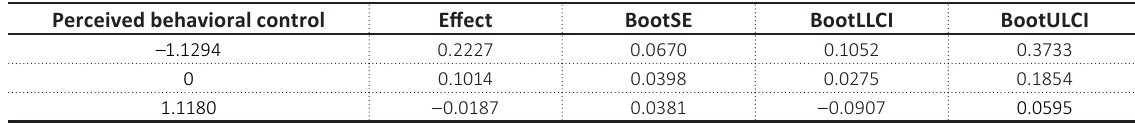
Table 7. Conditional effects of subjective norm on purchase intention Perceived behavioral control